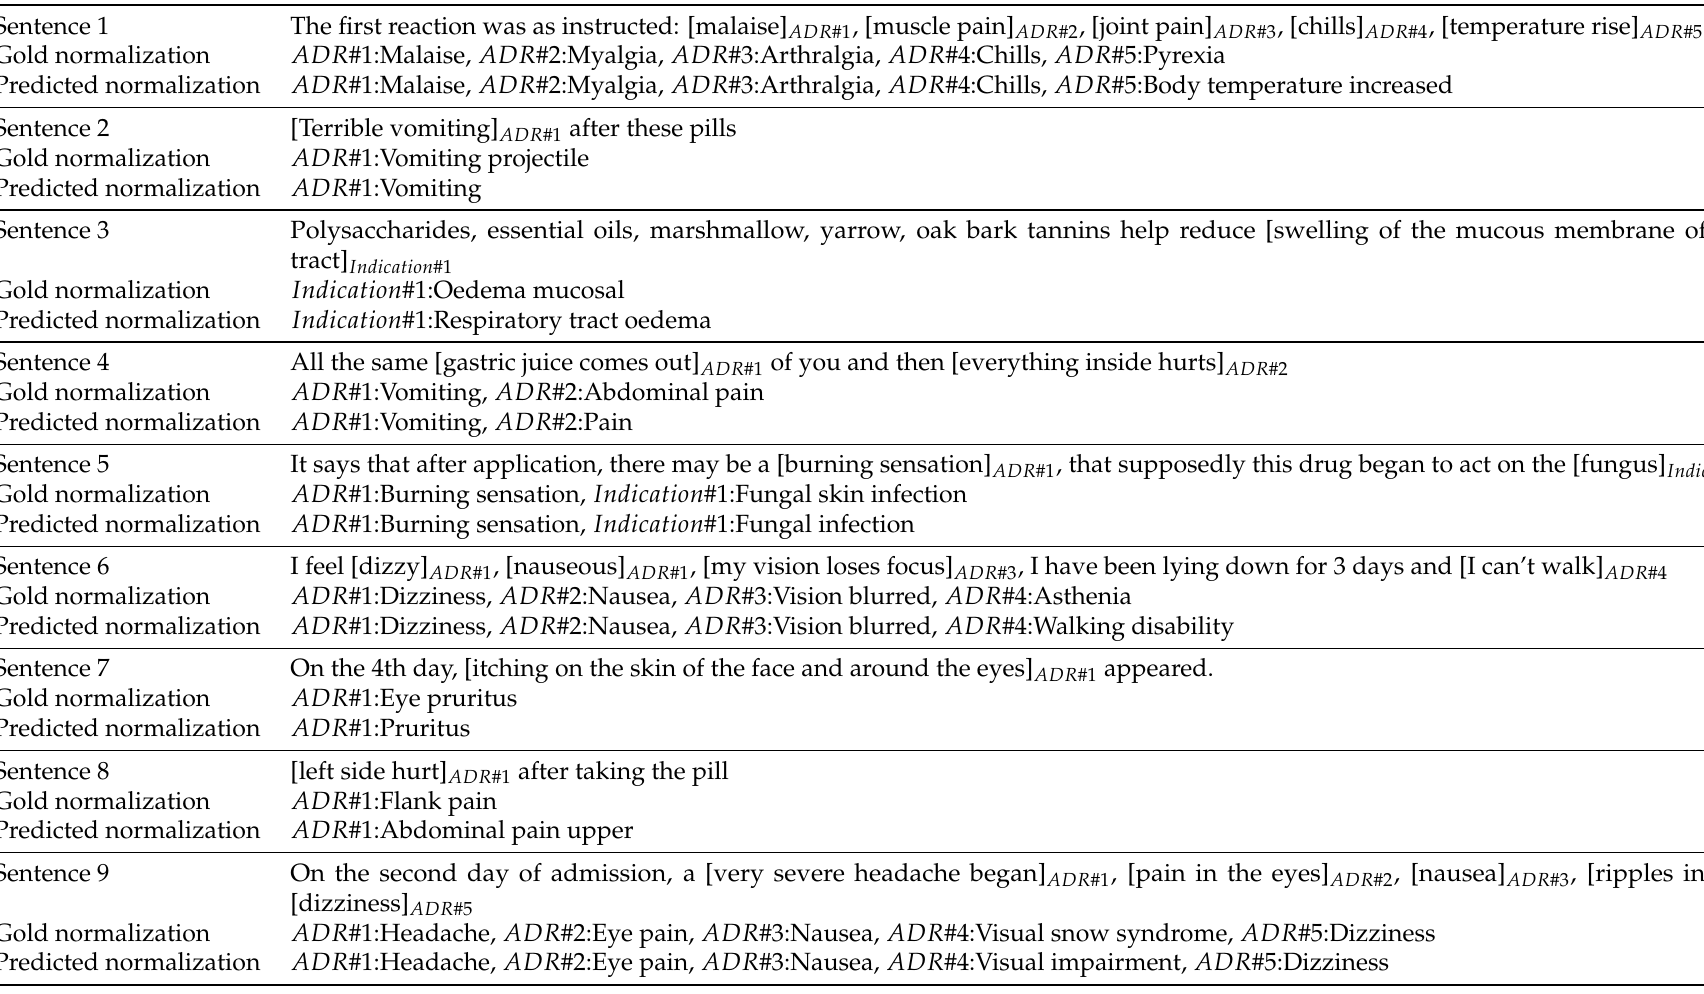
Table 7. Examples of the normalization for RDRS corpus with translation to